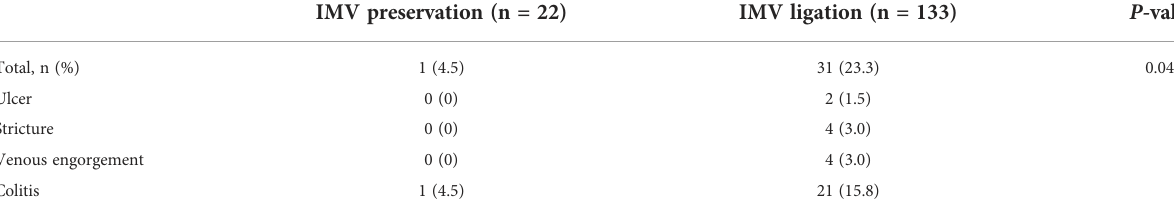
TABLE 3 Intestinal complications on computed tomography and using colonoscopy.